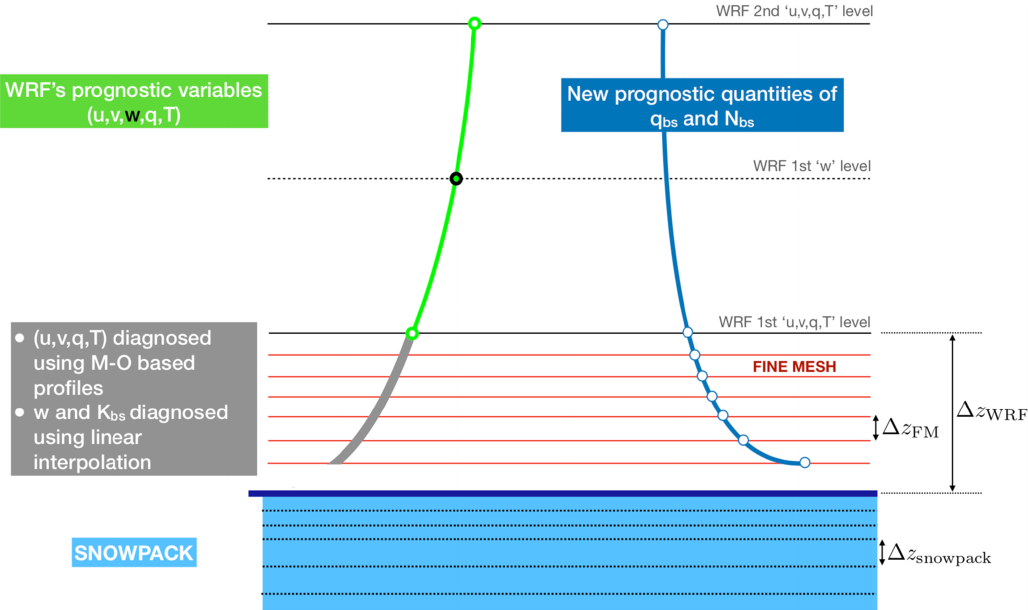
Figure 1. Vertical layering of the atmosphere and the snowpack. WRF’s vertical mesh is staggered with vertical velocity ( w ) solved at mid-points (dotted black line) between the levels of the other prognostic variables (solid black line), such as horizontal velocities ( u,v ), temperature ( T ), and water mixing ratios ( q ). Numerical nodes lying on the solid black line are also called mass points. The new prognostic variables for blowing snow ( q bs , N bs ; blue profile) are solved on mass points and, additionally, on a newly introduced fine mesh (in red). On the fine mesh, the prognostic variables ( u , v , q , T ) are diagnosed using Monin–Obukhov similarity theory (grey section of the green vertical profiles). Vertical velocity ( w ) and the turbulent diffusion coefficient ( K bs ) are linearly interpolated between the surface and first w level. (cid:49)z FM indicates the vertical layer thickness of the fine mesh (FM), (cid:49)z WRF indicates the layer thickness of the first WRF model level, and (cid:49)z SNOWPACK shows the layer thickness of the SNOWPACK model